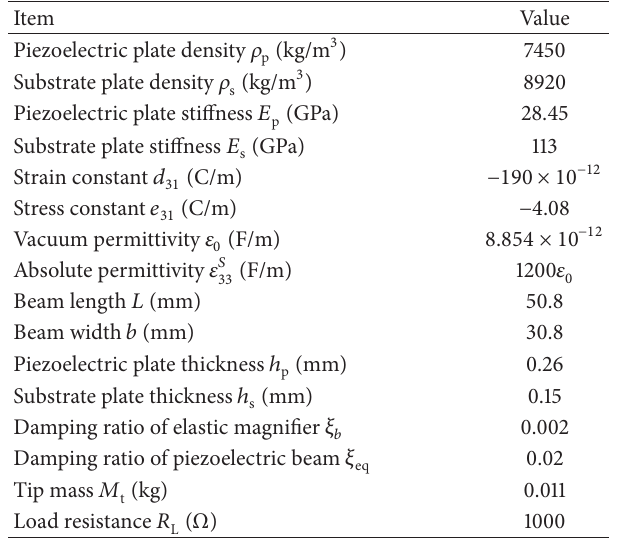
Table 1: Material and geometric parameters of the CPEH.